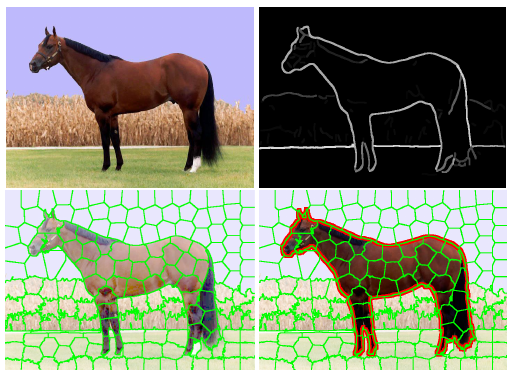
Figure 1: Overview of our approach for figure-ground segmen- tation: (a) original image; (b) contour image (Pb-detector); (c) superpixel segmentation (SLIC), in which superpixel resolution is chosen to ensure that target boundaries are reasonably well ap- proximated by superpixel boundaries; (d) figure-ground segmen- tation as a superpixel selection problem (the red boundary over- lays with the superpixel segmentation image for